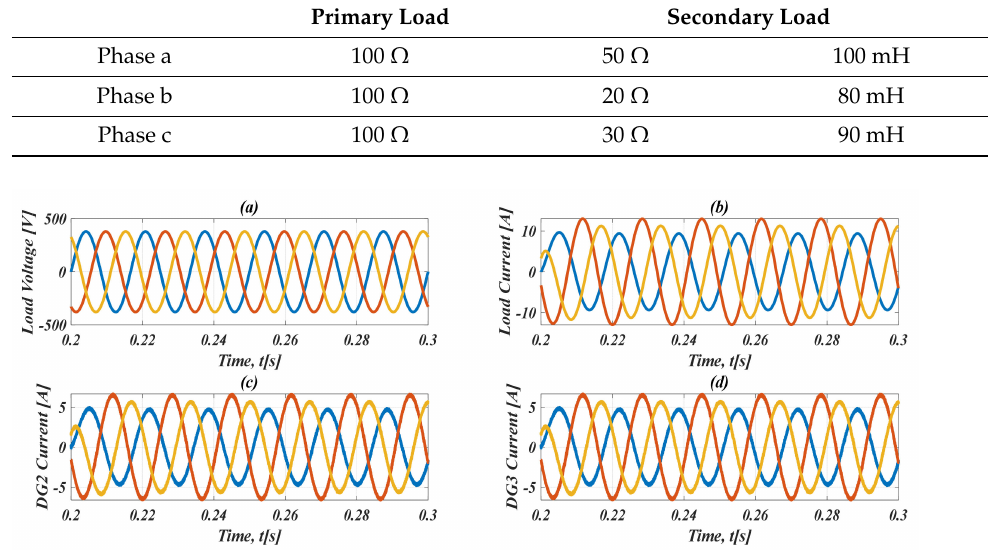
Figure 5. Load and Current Waves in Transient Operation Under Asymmetric Inductive-Resistive Load: ( a ) Load Voltage, ( b ) Load current, ( c ) DG2 Current, ( d ) DG3